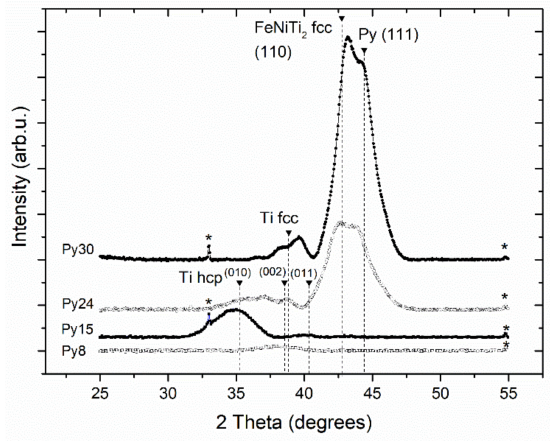
Figure 2. X-ray diffraction specular scans for all the samples studied. The asterisks indicate minor reflections of the Si